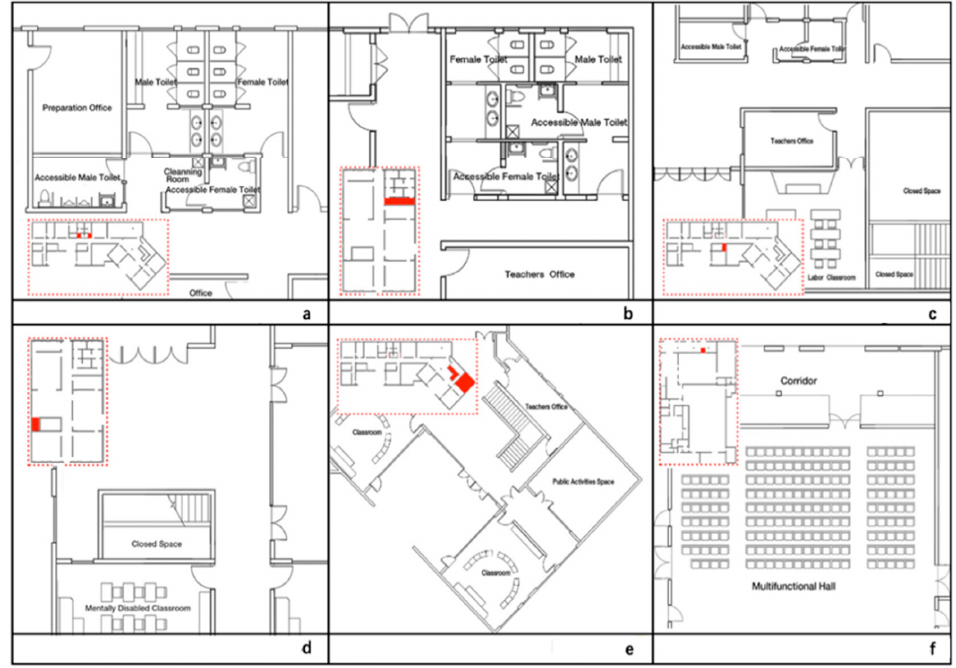
Figure 4 Figure 4. The distribution of the lowest VE areas in the public environment of the